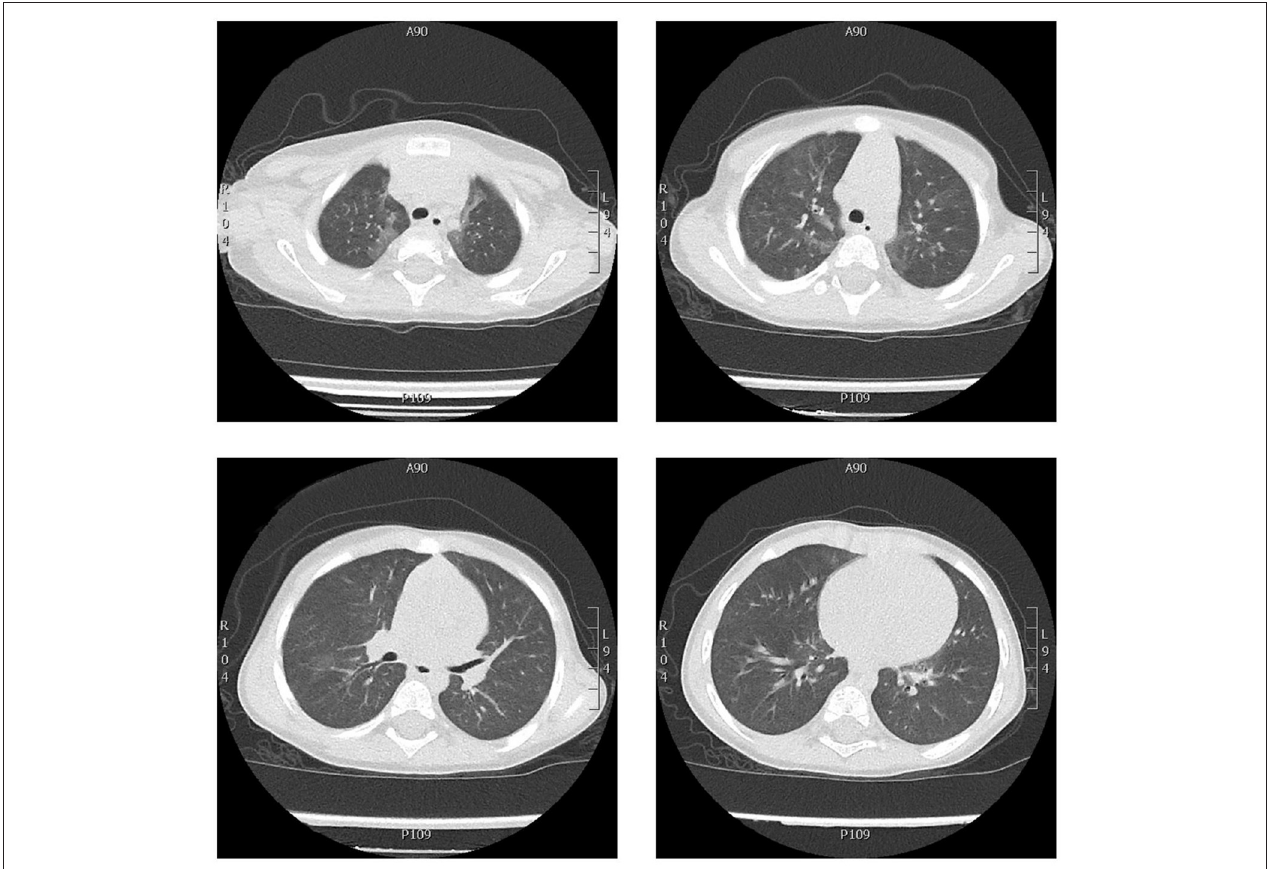
FIGURE 2 | Chest CT axial scan showing ground-glass thickening in both lungs, more evident in the upper and the lower left lobes, less extended and more nuanced than the CT scan performed 6 months before. No signs of interstitial fibrosis.